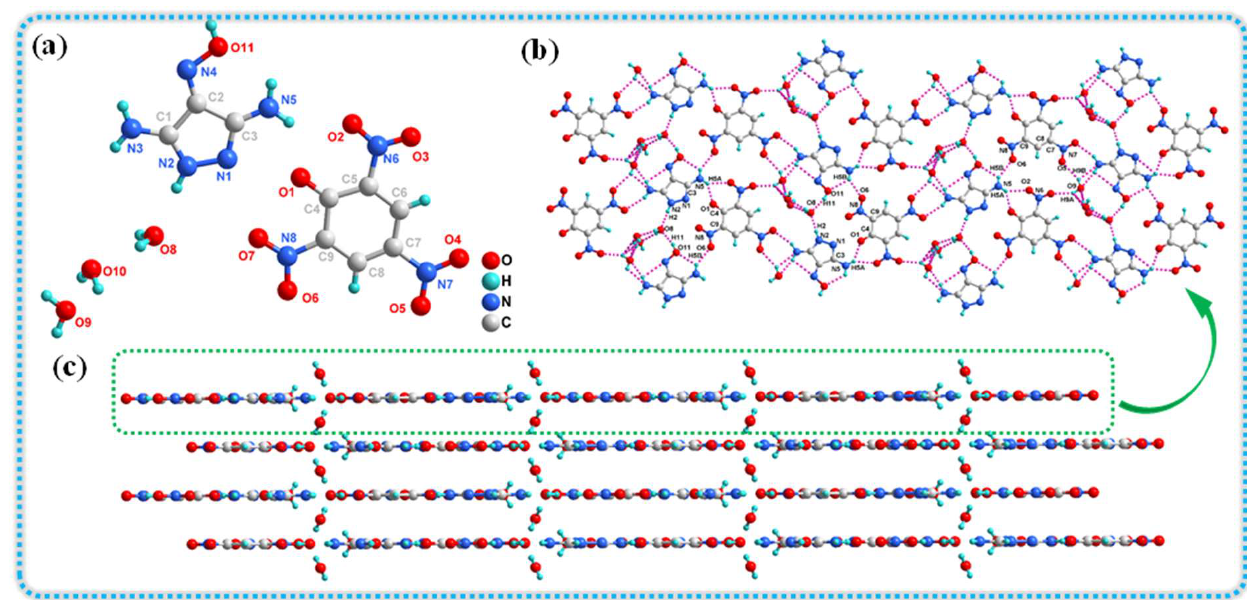
Figure 4. ( a ) Molecular structure of DAPOT·3H 2 O; ( b ) Hydrogen bonding network of DAPOP·3H 2 O; ( c ) Crystal stacking of DAPOT·3H 2 O.